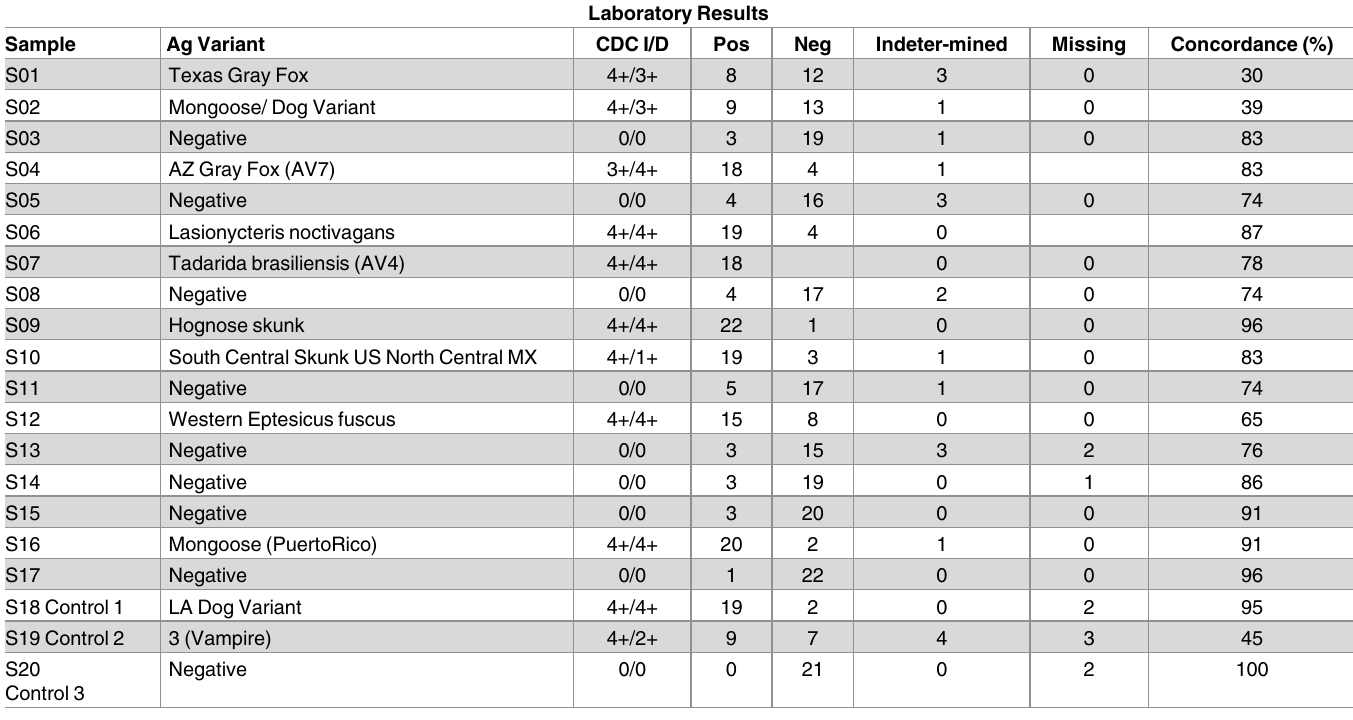
CDC I/D: CDC determined values for Staining Intensity and Antigen Distribution Pos: Number of laboratories reporting the sample positive for rabies Neg: Number of laboratories reporting the sample negative for rabies Inconclusive: Samples with inconclusive result as classified by laboratory, unable to determine a positive or negative results. Excluded from the sensitivity and specificity calculations, but included in the kappa and concordance calculations. Concordance: percent of laboratory results in agreement the CDC